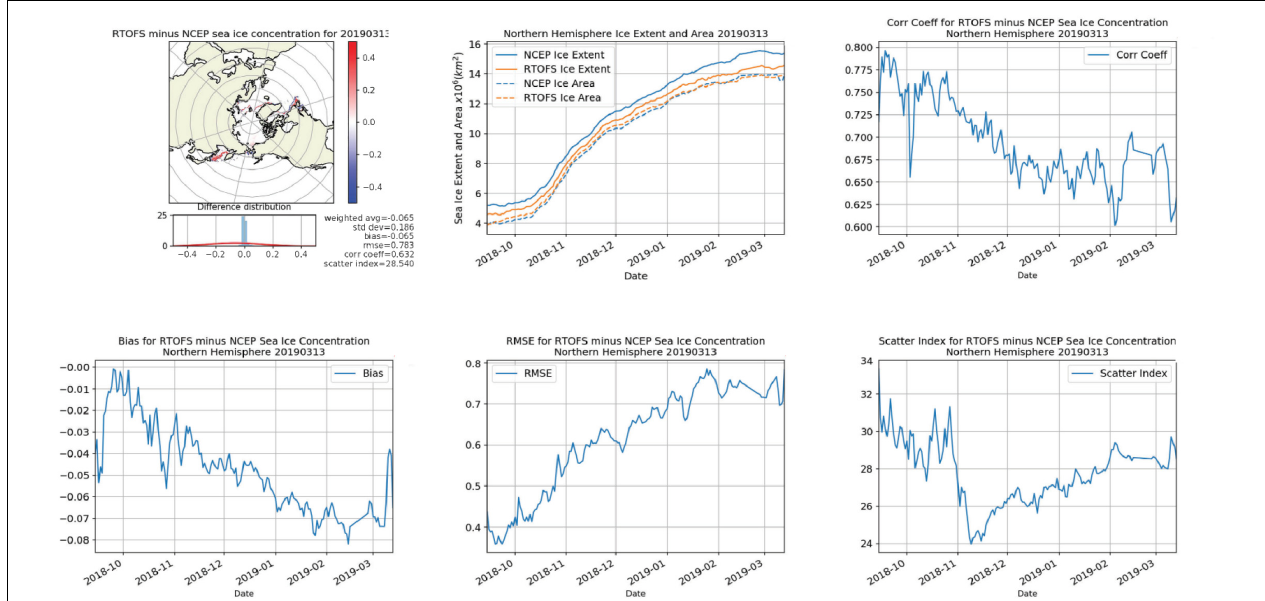
FIGURE 3 | Class-1 metrics of Arctic ice concentrations comparing Global RTOFS model results and NCEP Ice Analysis. Difference field of sea ice concentrations for a single day and time series of descriptive statistics collected for the previous 180